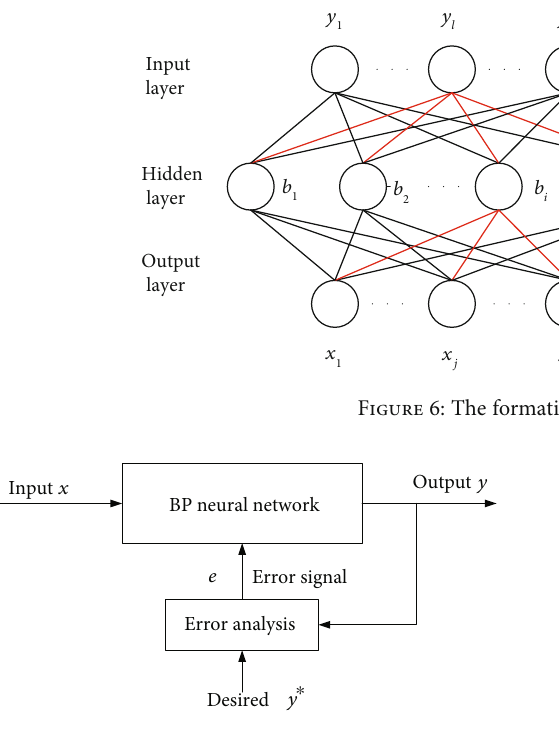
Figure 7: The adjustment process of BP neural network.